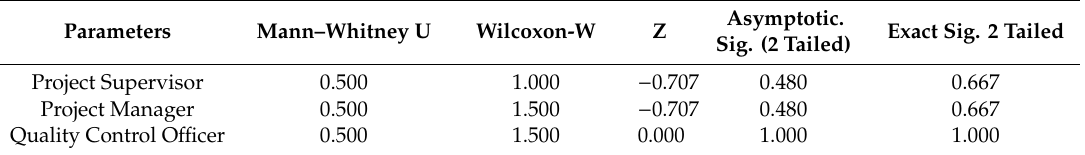
Table 18. Mann–Whitney U test on performance expectation of lean thinking and Industry 4.0 in the construction industry.